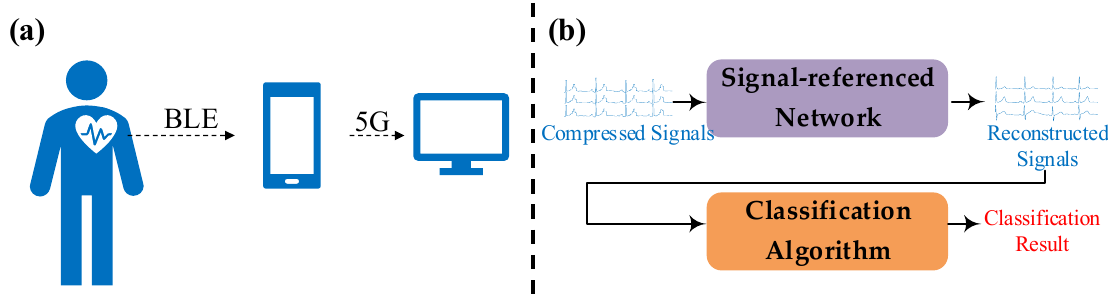
Figure 1. A structural diagram of our wearable ECG monitoring system. ( a ) The signals’ transmission path. ( b ) The schematic of the server.